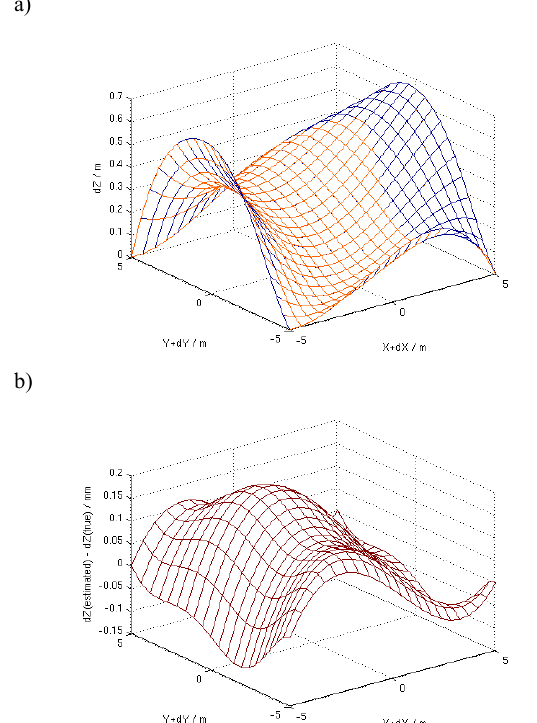
Figure 3. a) Estimated and true deformation in red and blue, respectively, for the deformation in Eq. 8 with weak imaging geometry. b) Difference between the estimated and true Z coordinates of the deformation in millimeters.